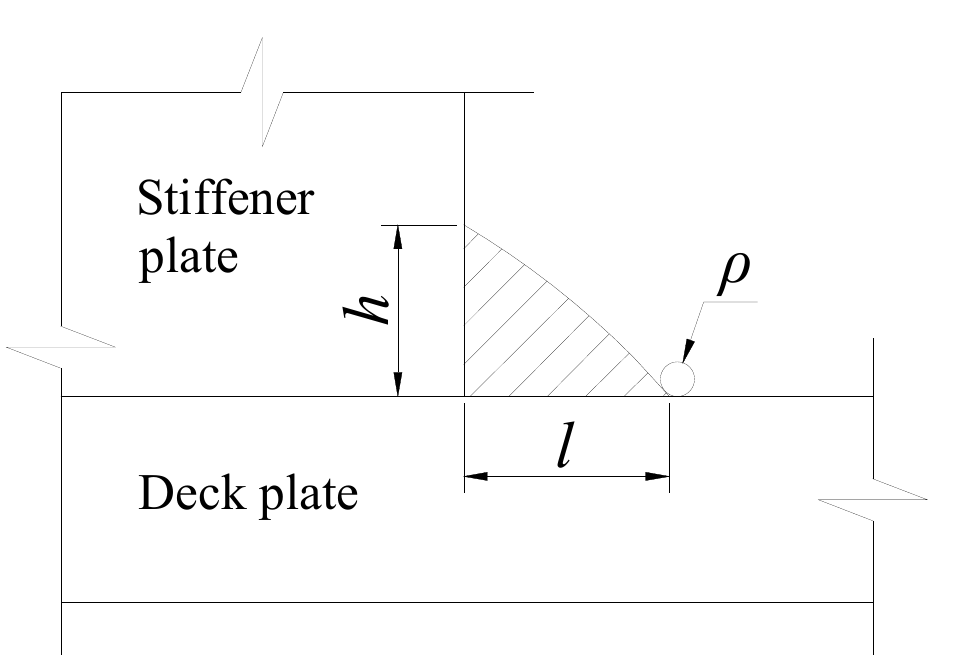
Figure 14. Geometric parameters of welds. Table 6. Weld measurements. Specimen